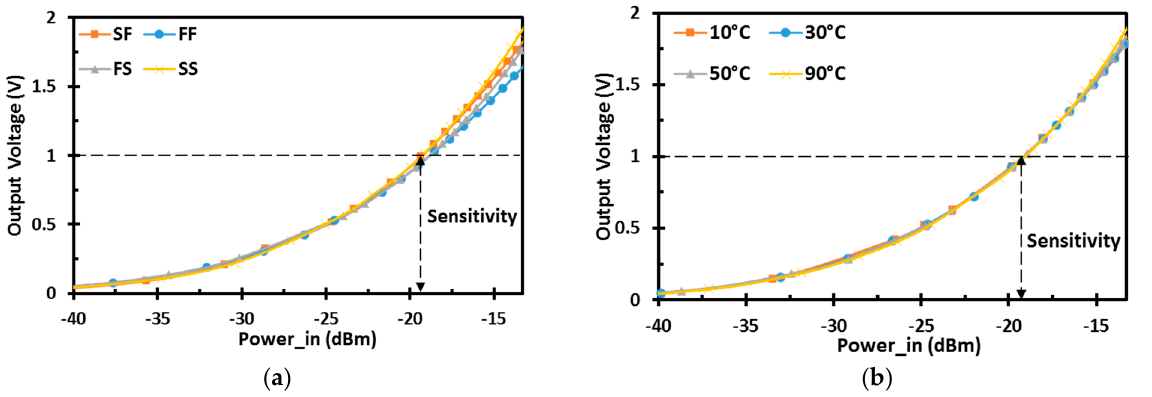
Figure 11. Output DC voltage of the proposed rectifier: ( a ) at different process corners; ( b ) at different temperature levels.